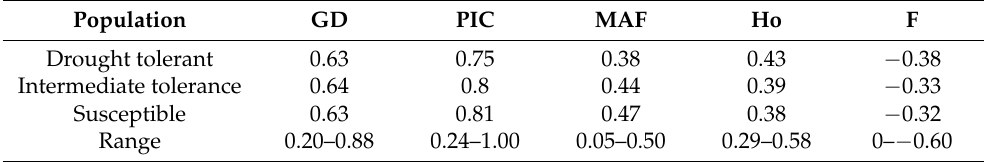
Table 5. Genetic parameters of 97 wheat genotypes genotyped with 16,382 SNP markers.